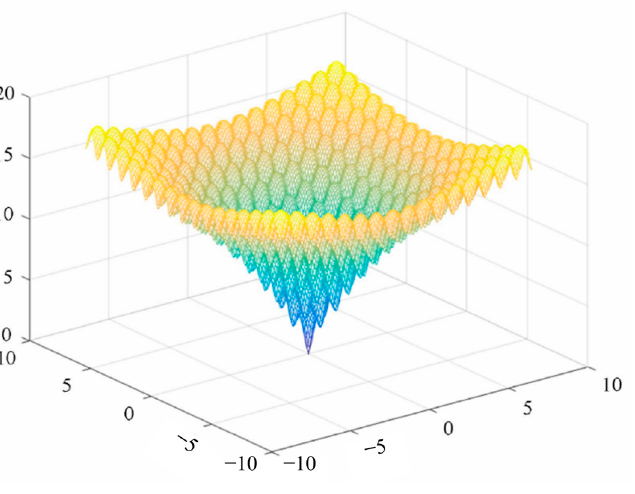
Figure 4. Ackley function image.